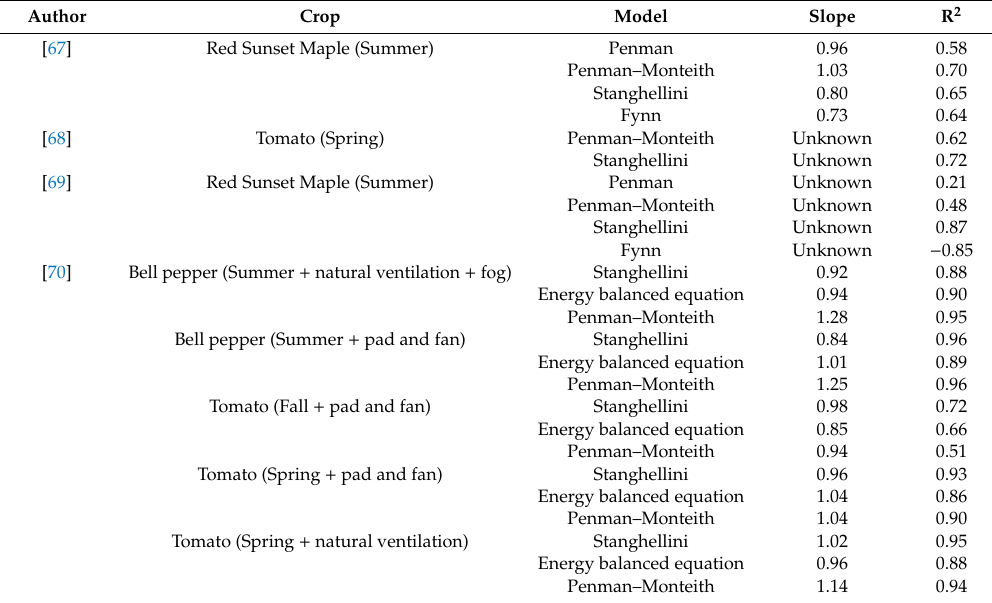
Table 3. Results of the studies [67–70] comparing di ff erent transpiration models. Slope of the regression line between experimental and numerical results and corresponding coe ffi cient of determination (for each study, the best model is given in bold type)